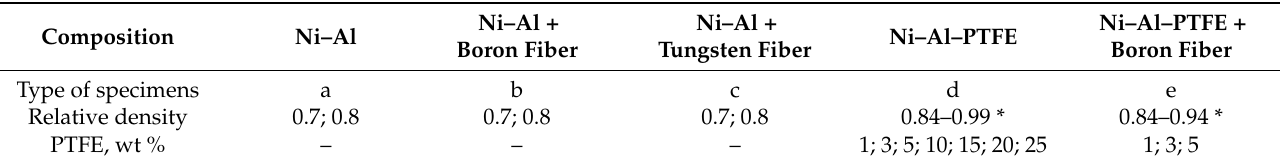
Table 2. HT modes for samples of the Ni–Al